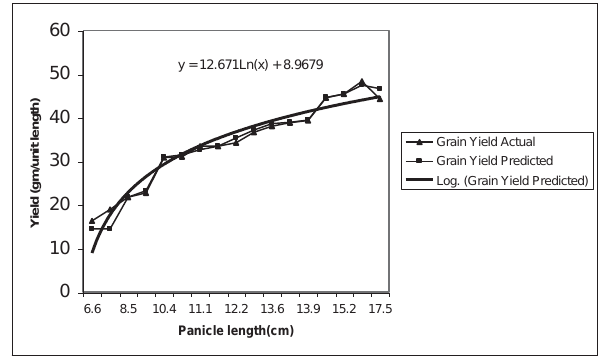
Figure 4. Predicted yield vs. actual yield with panicle length as input.